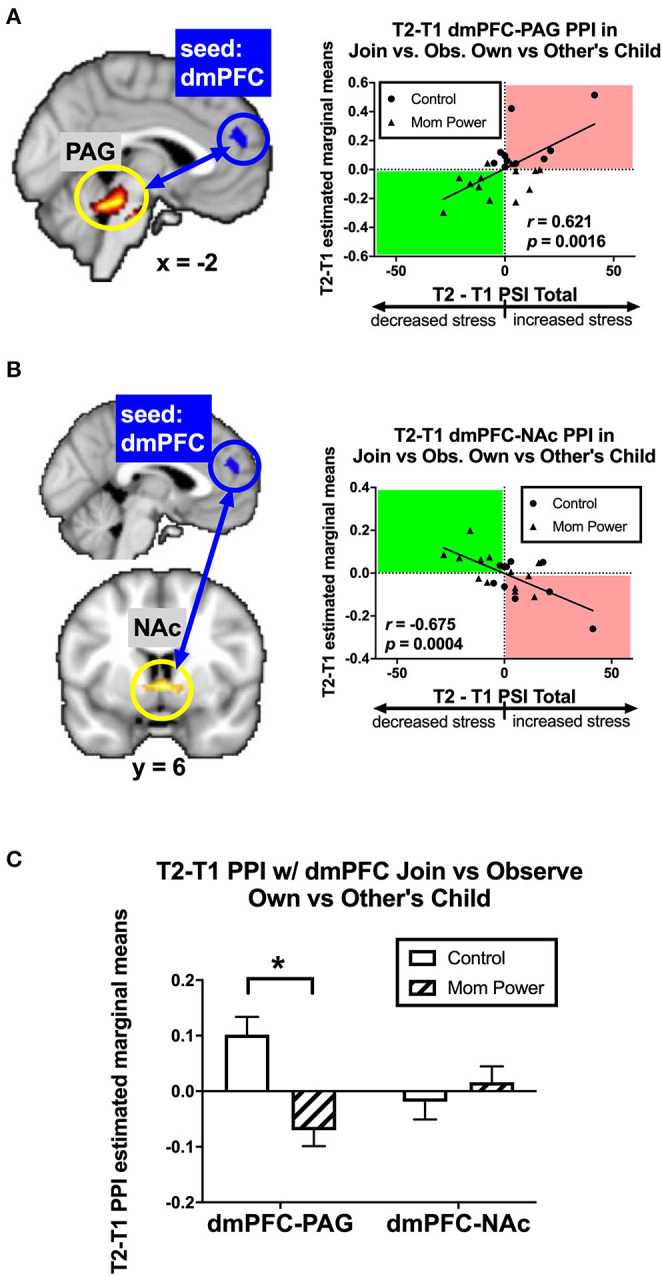
From T1 to T2 in the clinical study sample, the T2-T1 differences in parenting stress index (dPSI) were positively and negatively associated with the concomitant increases in the MMR(all) [Join[Own vs. Other Child] vs. Observe[Own vs. Other Child]] differential functional connectivity [MMR(all)-dependent PPI] between the dmPFC and PAG (A) and that between the dmPFC and NAc (B), respectively, each with the dPSI depicted on the x-axis, against the T2-T1 difference in the region's differential response on the y-axis, in the scatter plots. The Pearson's correlation r scores and p-values are embedded in the plots. The MP vs. Control differed in the MMR(all)-dependent PPI between dmPFC and PAG, but not that between dmPFC and NAc, with the bar charts of each region's mean (±s.e.) depicted in (C). *p < 0.05.